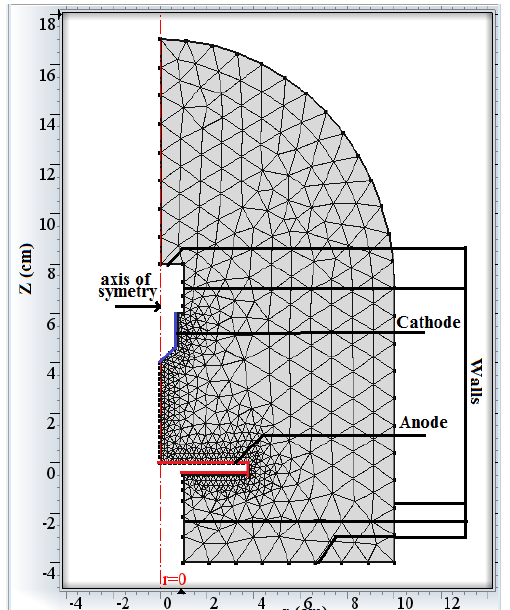
Fig. 2: Definition of 2D axial-symmetric model boundaries identical with experimental chamber.